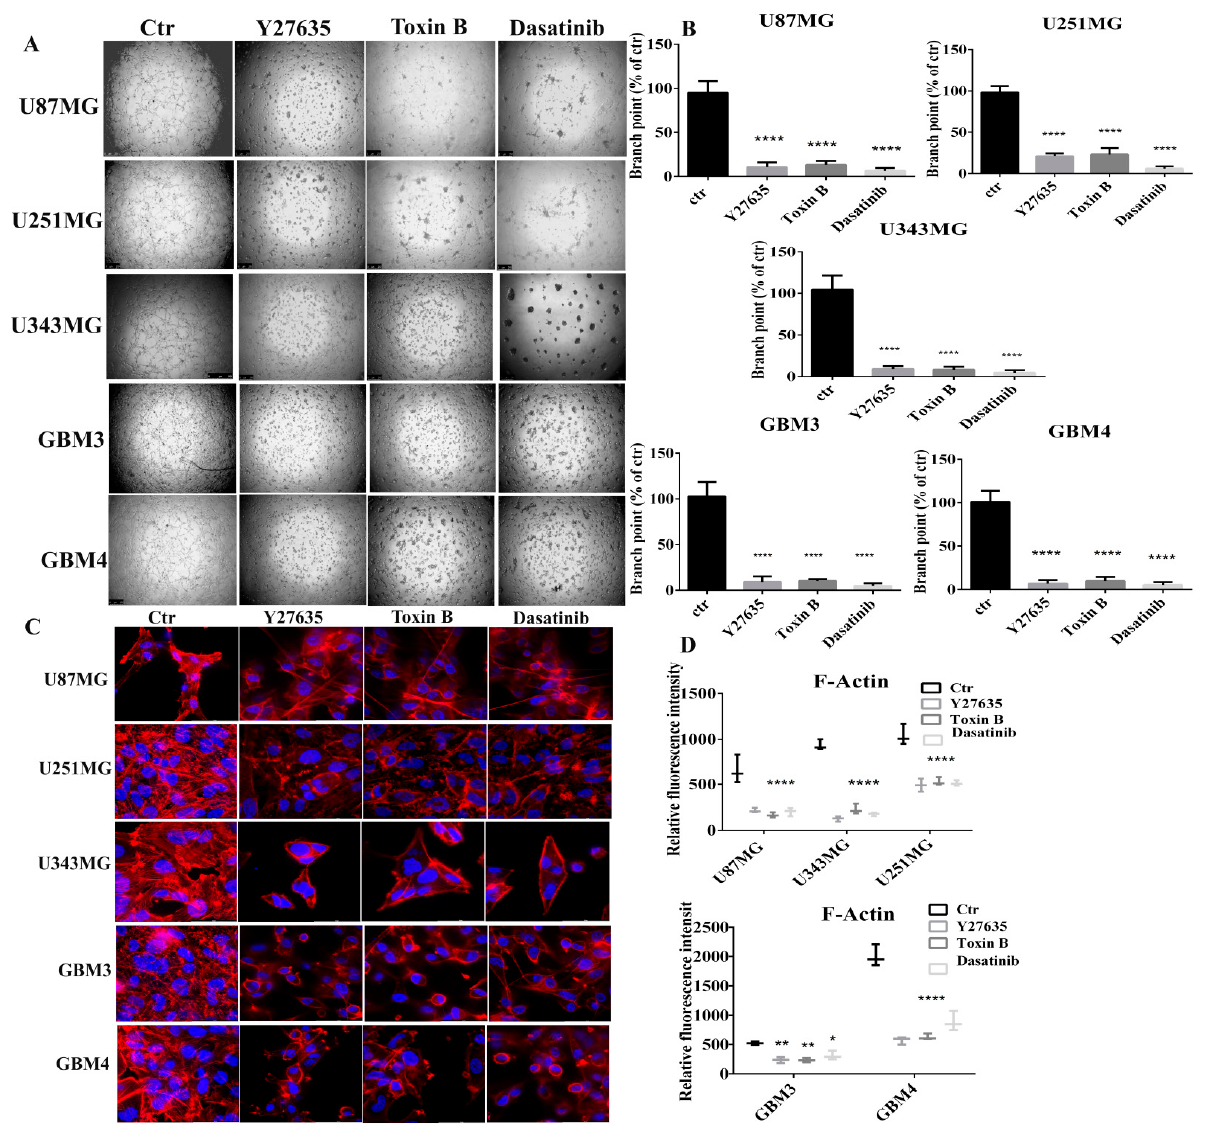
Figure 6. Effect of iPA on actin stress fibers. Inhibition of vasculogenic mimicry by Y27635 and Toxin B of ( A ) GBM stabilized and primary cell lines. Y27635, Toxin B, and Dasatinib inhibit vasculogenic mimicry in GBM and primary cells. ( B ) Branch point (sites of intersection of at least three tubes) number in each well was counted. Immunofluorescence staining of Actin (red signal, Phalloidin) to show changes in the levels of stress fibers in ( C ) GBM stabilized and primary cell lines. ( D ) The rate of F-actin was quantified and data are plotted as boxplots. Results are expressed as the mean ± SD of four independent experiments conducted in triplicate. (ANOVA, * p < 0.05, ** p < 0.01, **** p <